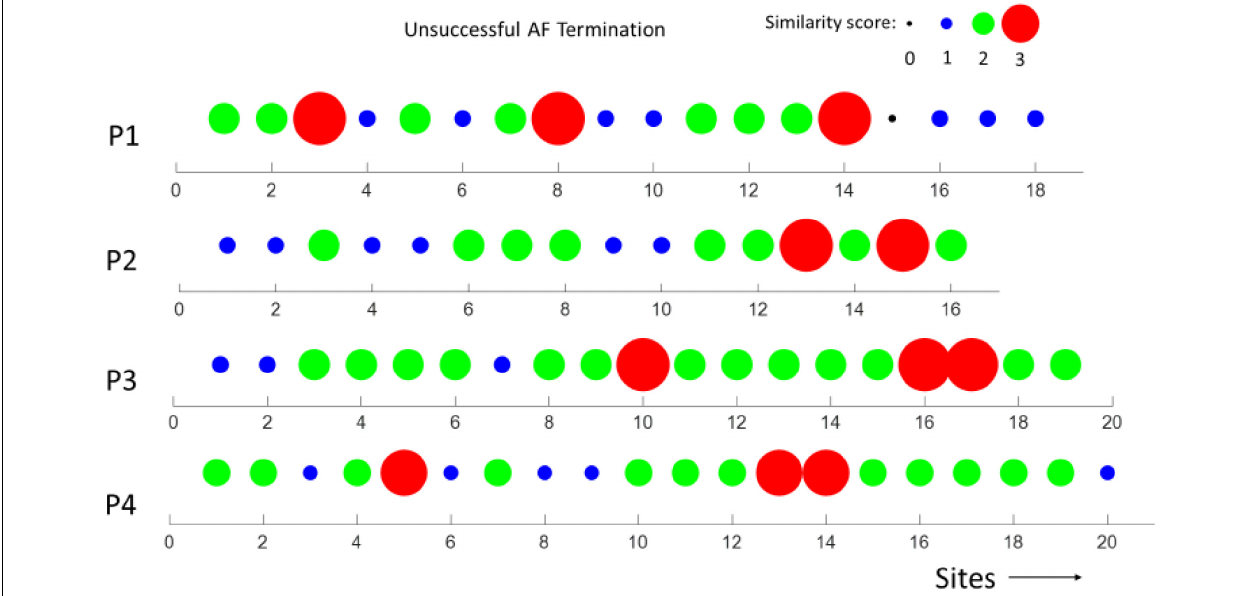
FIGURE 6 | Similarity scores calculated at different spatial sites in m = 4 patients with unsuccessful AF termination. Notably, the presence of several spatial sites (potential active AF sites) with a high similarity score (3, red) in all the patients.